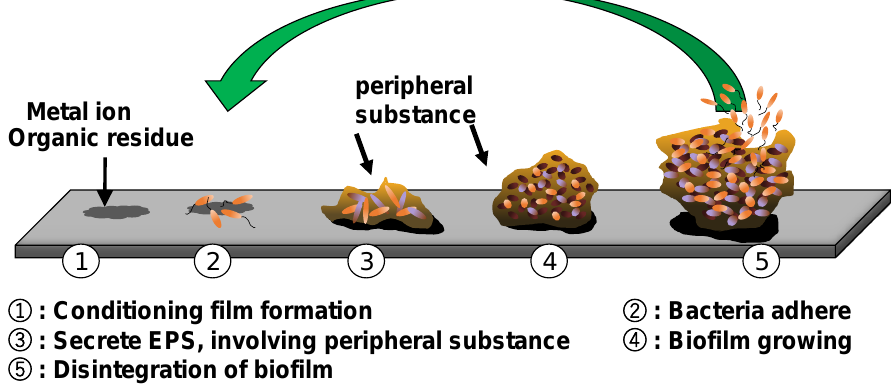
Figure 1. Schematic of biofilm formation.